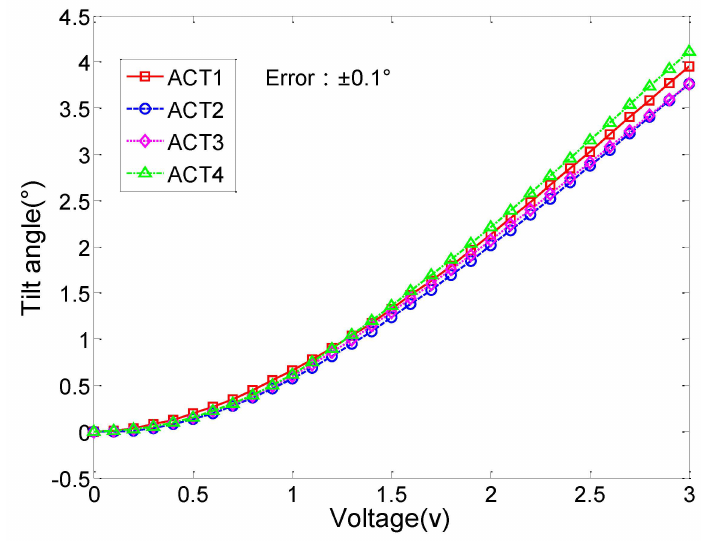
Figure 3. Tilt angle vs. voltage curve. The actuators were driven one by